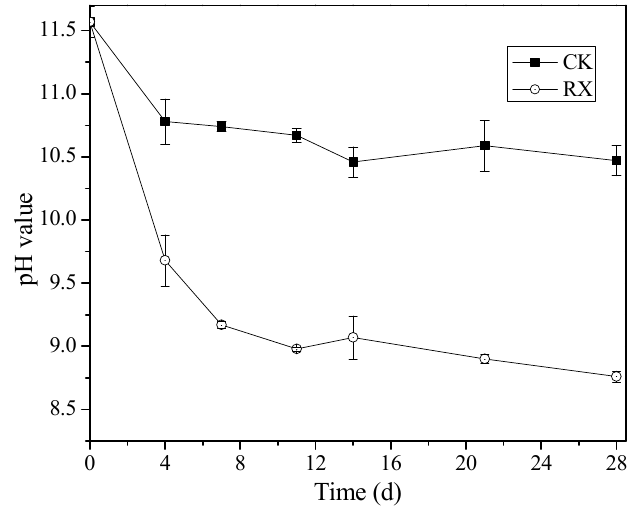
Figure 3. Change in pH value of BR with (RX) and without (CK) the application of ZH-1. These results are presented as mean ± standard deviation ( n = 3).